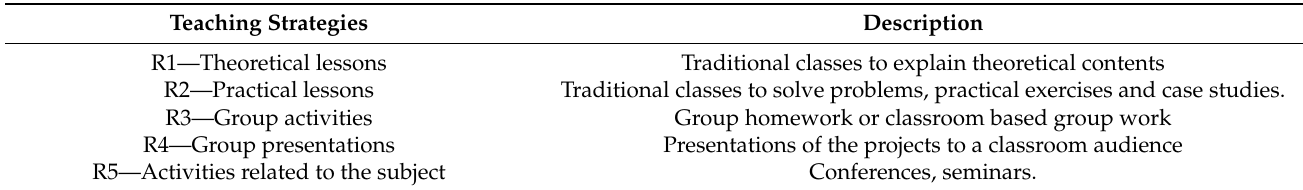
Table 3. Teaching strategies available for lecturers.